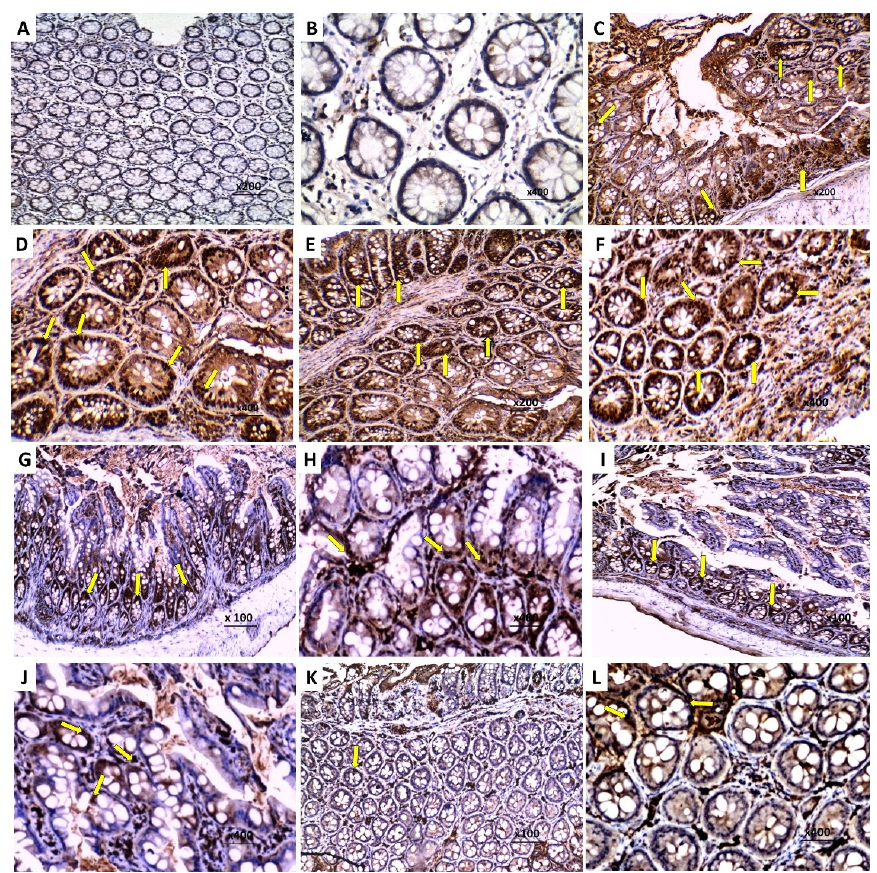
Figure 7. Photomicrographs of sections of the colon of ( A ) and ( B ) The control untreated mice showing negative nuclear immunoreactivity to NF-κB (p65) (×200 and ×400, respectively); ( C ) and ( D ) DSS mice exhibiting strong positive nuclear immunoreactivity to NF-κB (p65) in the colonic glands epithelial cells (Arrows) (×200 and ×400, respectively); ( E ) and ( F ) DSS mice treated with CMC showing strong positive nuclear immunoreactivity to NF-κB (p65) in the colonic glands epithelial cells (Arrows) (×200 and х400, respectively); ( G ) and ( H ) DSS mice treated with perindopril exhibiting decreased immunoreactivity to NF-κB(p65) (moderate immunostaining) (Arrows) (×100 and ×400, respectively); ( I ) and ( J ) DSS mice treated with ambrosin showing decreased immunoreactivity to NF-κB (p65) (moderate immunostaining) (Arrows) (×100 and ×400, respectively); ( K ) and ( L ) DSS mice treated with perindopril/ambrosin combination revealing marked decrease in the immunoreactivity to NF-κB (p65) (mild immunostaining) (Arrow) (×100 and ×400, respectively). 3.9. Perindopril and/or Ambrosin Combatted the Electron Microscopic Changes of the Colonic Tissues Induced by DSS Administration In the control untreated group, the apical microvilli of the columnar cells were clearly determined, and the junctional complexes between the adjacent cells were normal. The cytoplasm of these cells showed normal mitochondria, rough endoplasmic reticulum (RER), and heterochromatic nuclei with prominent nucleoli (Figure 8A). Specimens ob- tained from animals treated with DSS alone showed marked cellular damage in the form of loss of the apical microvilli, extensive cytoplasmic and perinuclear vacuolations, mito- chondrial swelling with the destruction of their cristae, dilated RER, and hyperchromatic compressed nucleus (Figure 8B–D). Administration of CMC to DSS-treated mice did not induce significant electron microscopic changes in the colonic tissues compared to mice treated with DSS alone (Figure 8E,F). Interestingly, mice treated with perindopril had par- tial loss of the apical microvilli, mild cytoplasmic vacuolation, and preserved normal